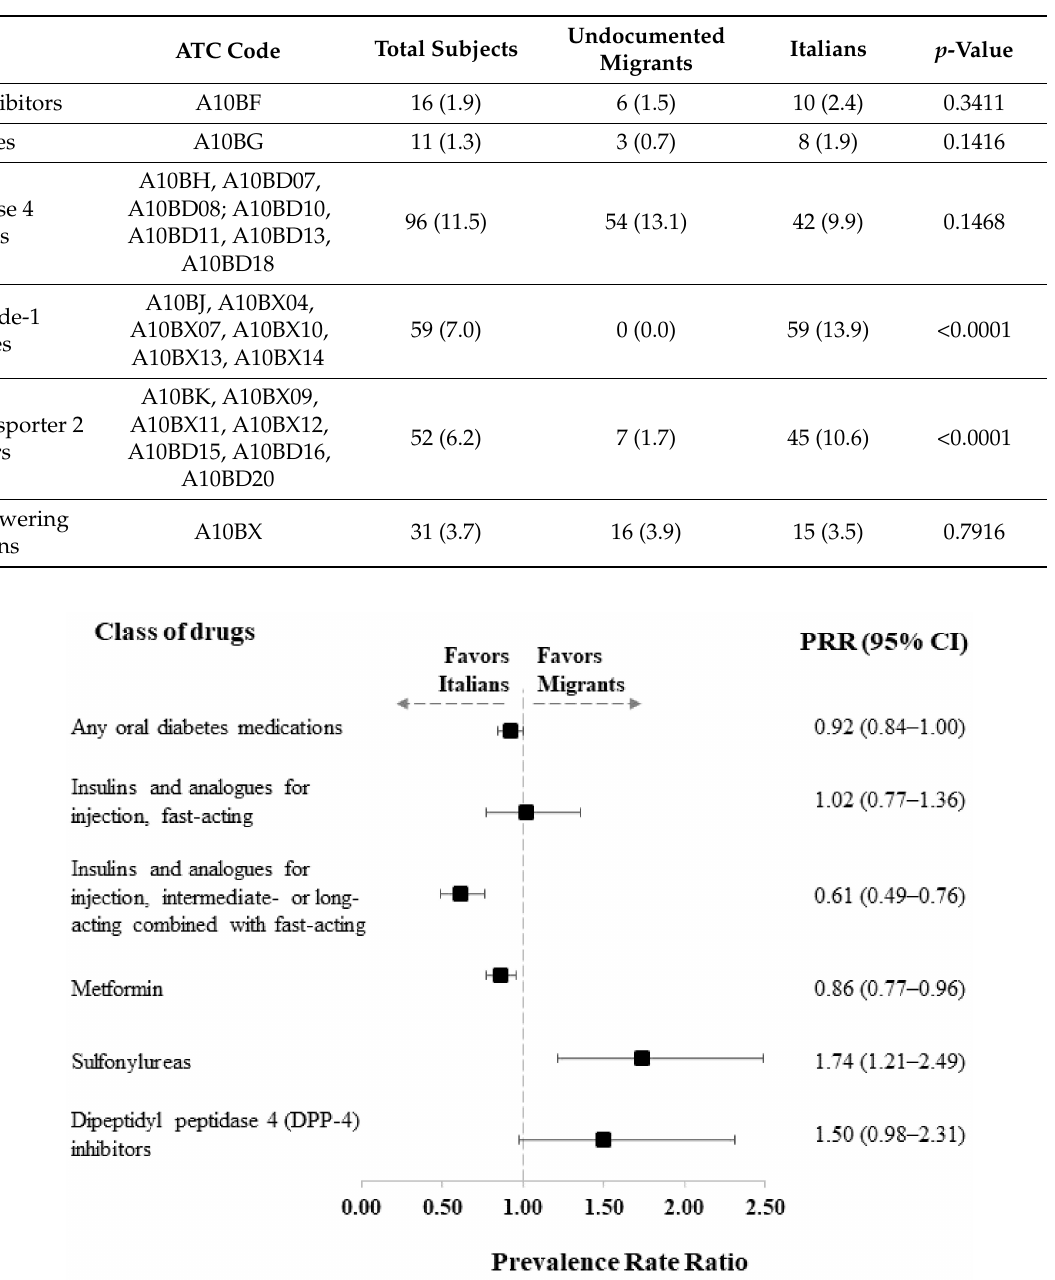
Figure 1. Prevalence rate ratio (PRR), along with 95% confidence intervals, estimated from a Poisson regression model for comparing the prevalence of use of selected antidiabetic drugs between undoc- umented migrants and Italians, adjusted for patients’ characteristics (age class, sex, comorbidities, and